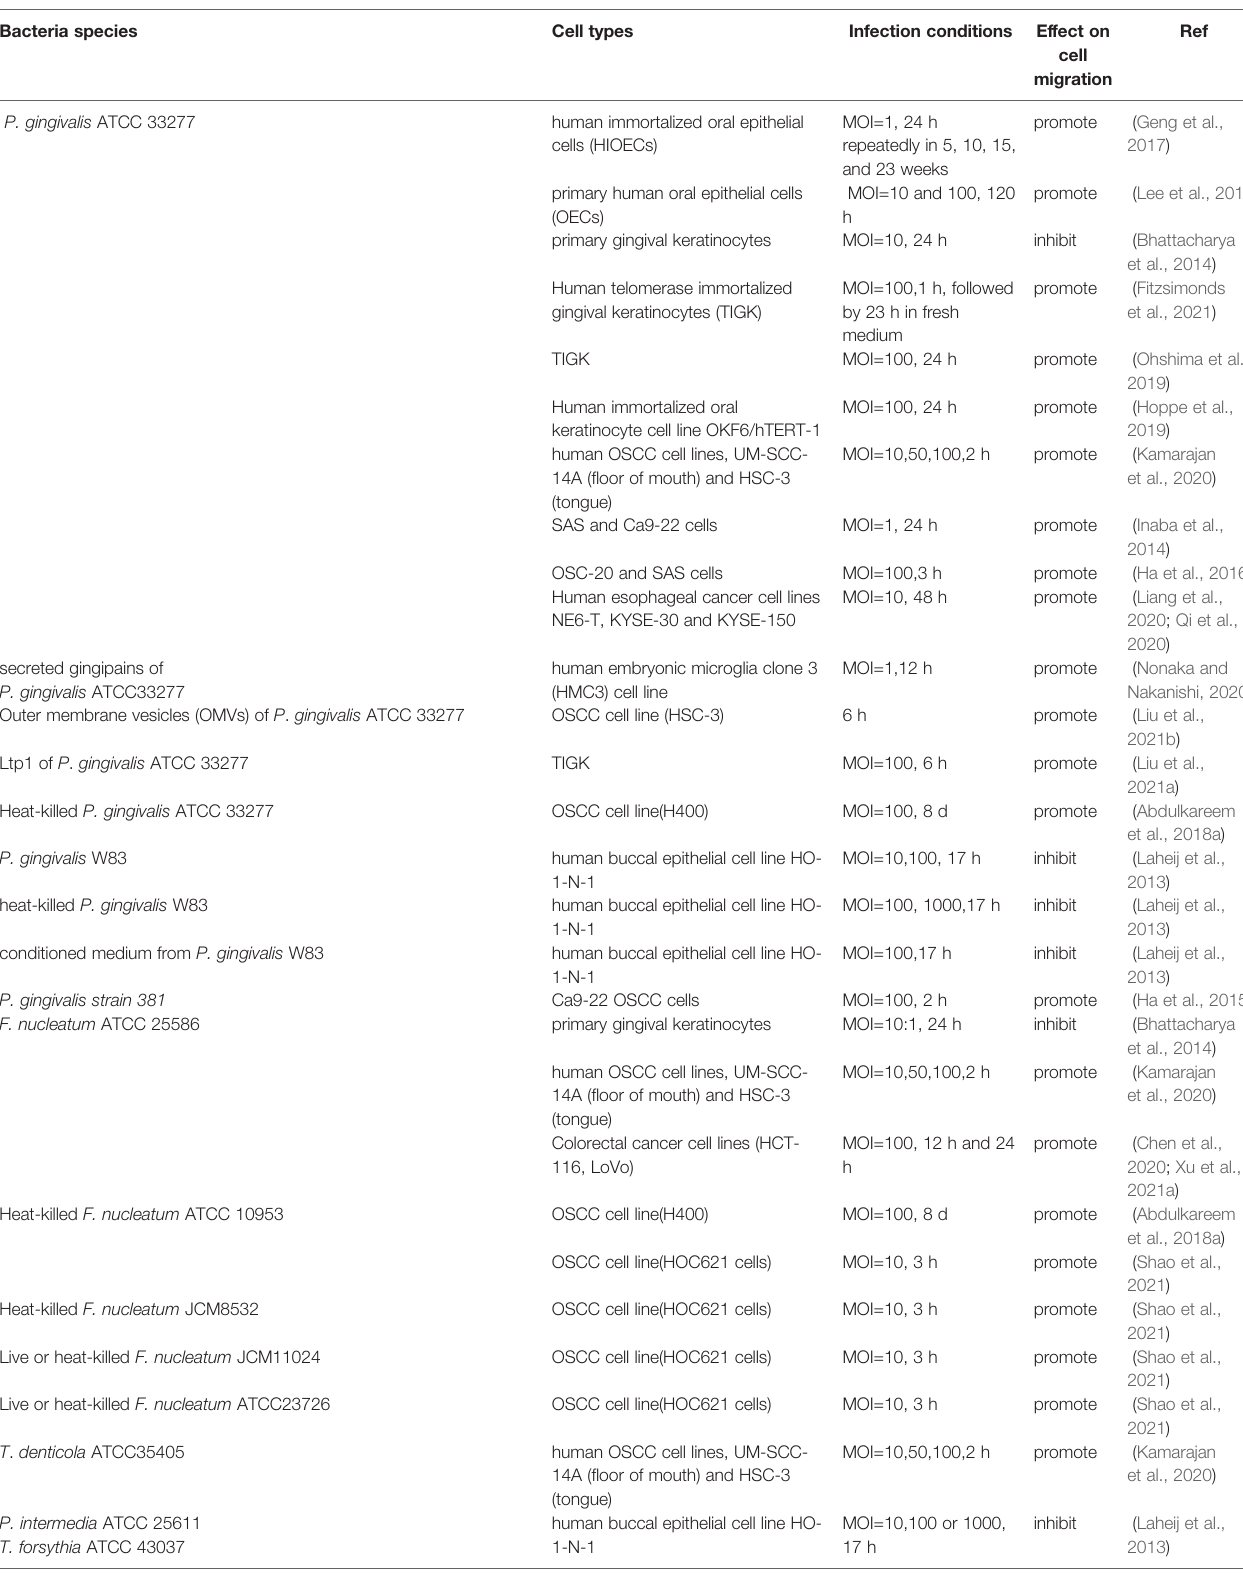
TABLE 1 | Summary of oral bacteria affecting cell